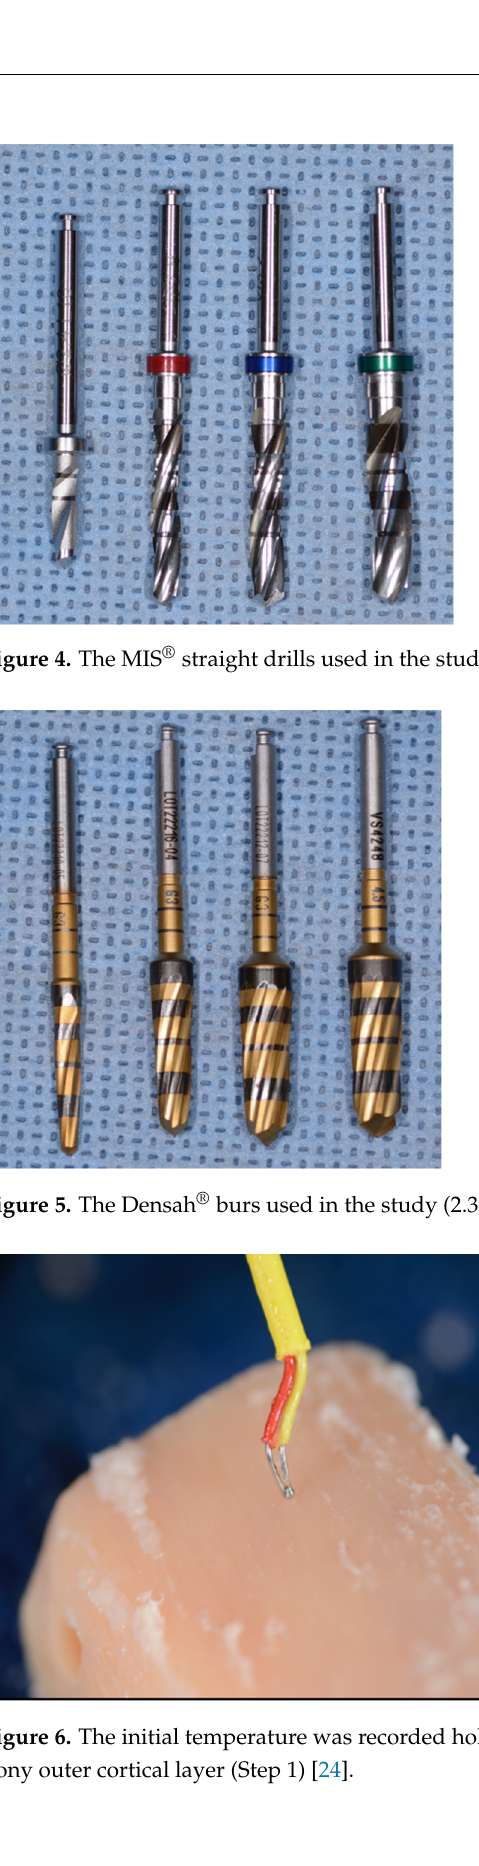
Figure 7. Each osteotomy was completed to the 6 mm depth, with external irrigation at 800, 1000, or 1200 RPM (Step 2) [24]. Figure 8. The thermocouple probe was inserted along the osteotomy wall and floor and the highest temperature value was recorded immediately after osteotomy preparation to the 6 mm depth (Step 3) [24]. This process was repeated following the sequential surgical protocol detailed above [24]. All values were recorded on an Excel ® spreadsheet for statistical analyses. ΔΤ was